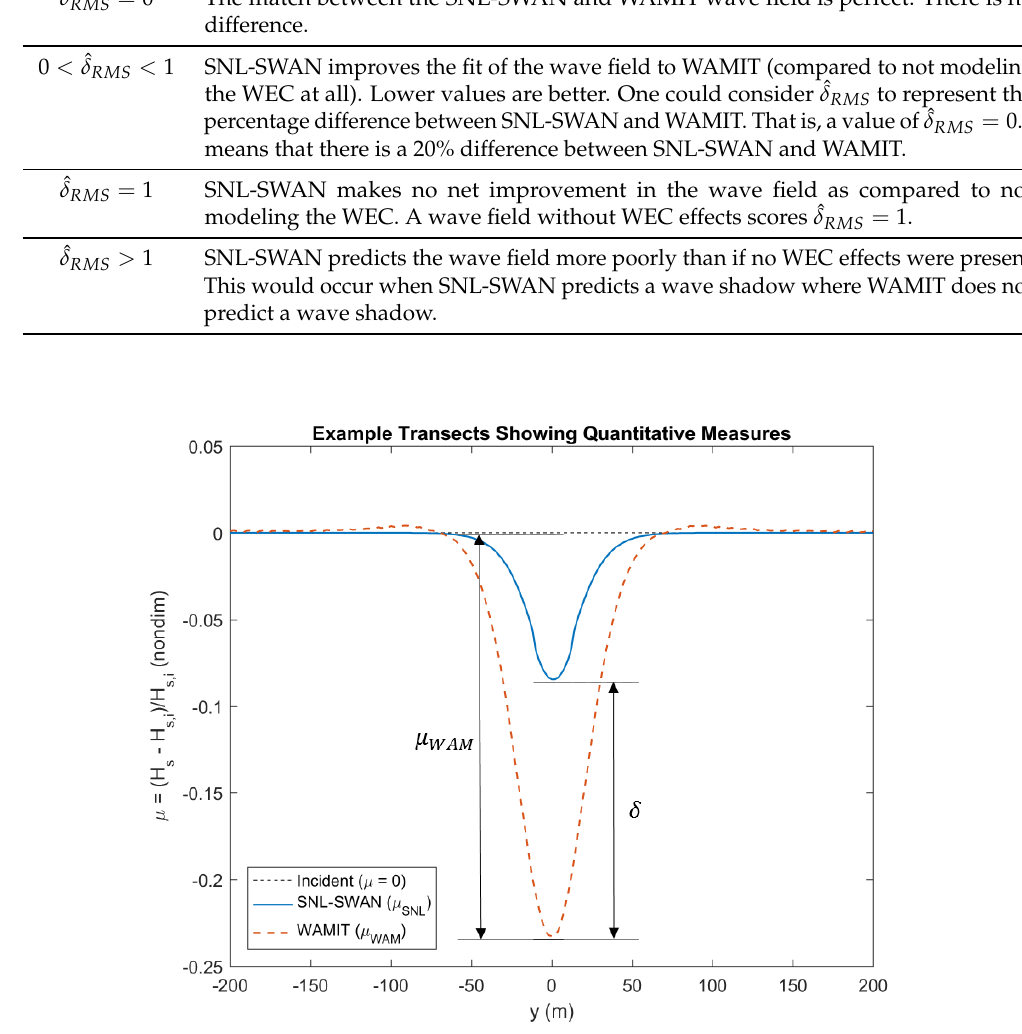
Figure 4. Example transects showing the quantitative